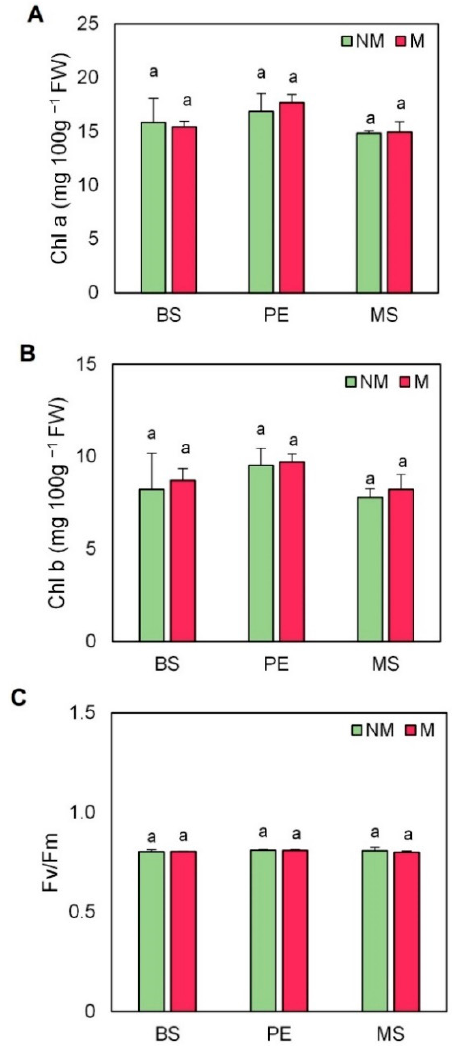
Figure 4. ( A ) Chlorophyll a, ( B ) chlorophyll b, and ( C ) chlorophyll fluorescence (Fv/Fm) in the leaves of escarole plants of the commercial variety “Bekele” cultivated under non-mycorrhizal (NM) and mycorrhizal (M) conditions and covered or not with mulching treatments. Bars show the means of five plants ± standard error. Different letters show significant differences among mulching treatments while the asterisk (*) indicates significant differences due to AMF inoculation within each mulching treatment according to Tukey’s and t -tests ( p ≤ 0.05). Abbreviations used: bare soil (BS),